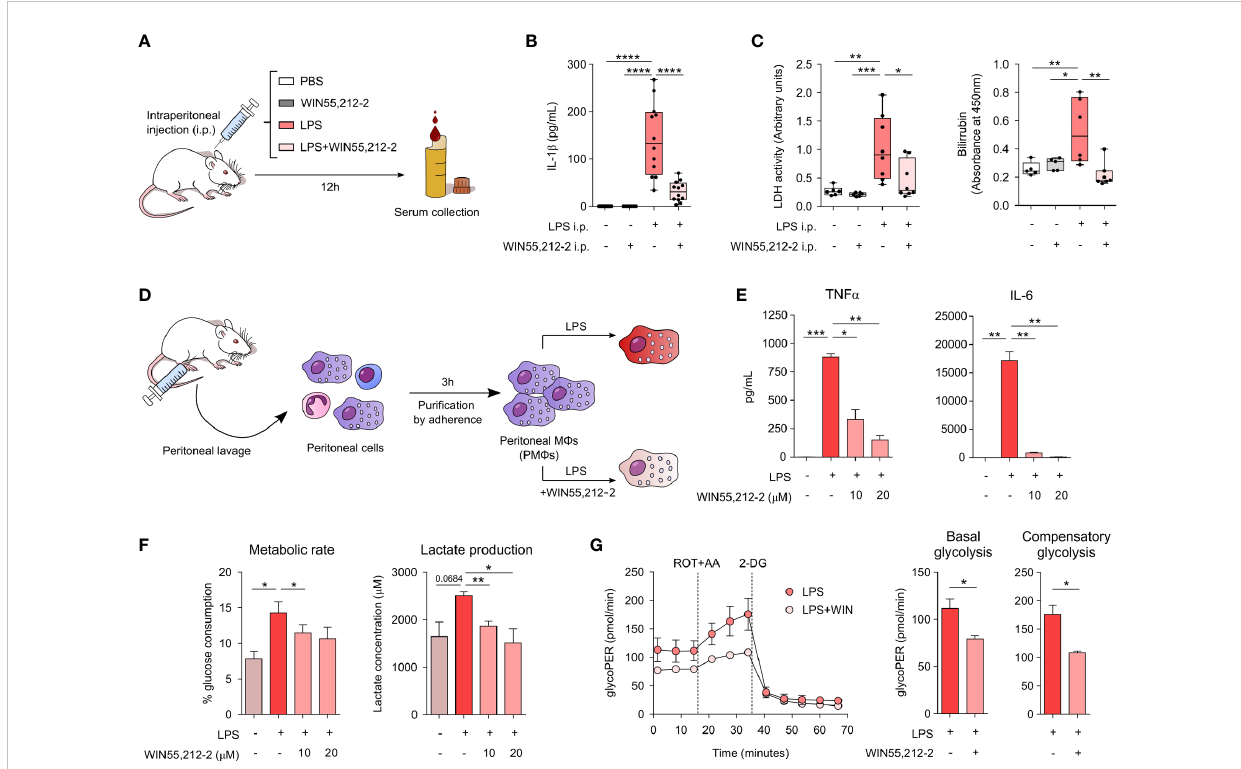
FIGURE 4 In vivo and ex vivo protective and anti-in fl ammatory potential of WIN55,212-2. (A) Schematic representation of the LPS-induced sepsis model. (B) Serum IL-1 b levels after 12h of intraperitoneal (i.p.) administration of PBS (Control), WIN55,212-2 (5mg/kg), LPS (20mg/kg) or LPS plus WIN55,212-2 (n=7-12). (C) Assessment of the clinical parameters LDH and bilirubin in the serum of mice treated with the indicated conditions (n=5-8). (D) Protocol for peritoneal macrophages (PM F s) isolation and activation. (E) Cytokine production by ex vivo stimulated PM F s with medium, LPS (10 ng/ mL) or LPS plus the indicated doses of WIN55,212-2 (n=4). (F) Percentage of glucose consumption and lactate concentration measured from cell- free supernatants of PM F s treated with medium, LPS or LPS plus the indicated doses of WIN55,212-2 (n=6). (G) Real-time analysis of glycolytic Proton Ef fl ux Rate (glycoPER) of PM F s after 18h stimulation with LPS or LPS plus WIN55,212-2 at basal conditions and after sequential addition of rotenone plus antimycin A (ROT+AA) and 2-deoxyglucose (2-DG). Graphs representing basal as well as compensatory glycolysis are included on the right (n=3). Statistical signi fi cance was determined by One-way ANOVA or Unpaired t test. *P<0.05, **P<0.01, ***P<0.001 and